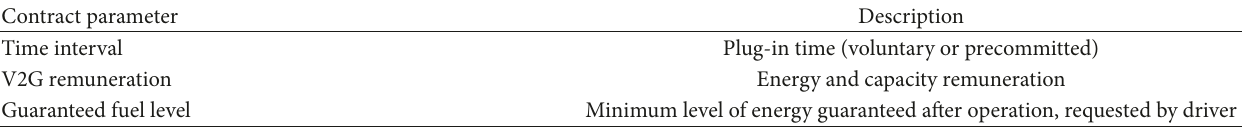
Table 3: Control-based contract